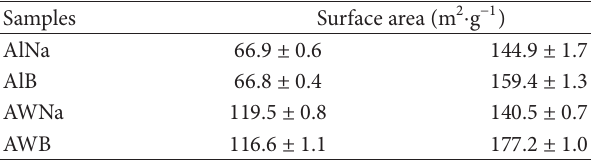
Figure 5: XRD patterns of 𝛾 -Al 2 O 3 obtained from AlCl 3 ⋅ 6H 2 O (AlNa, with NaOH, and AlB, with n-butylamine) and aluminum waste (AWNa, with NaOH, and AWB, with n-butylamine). Table 3: Diffraction angle, reticular space, and crystallite size of the hkl index 400.